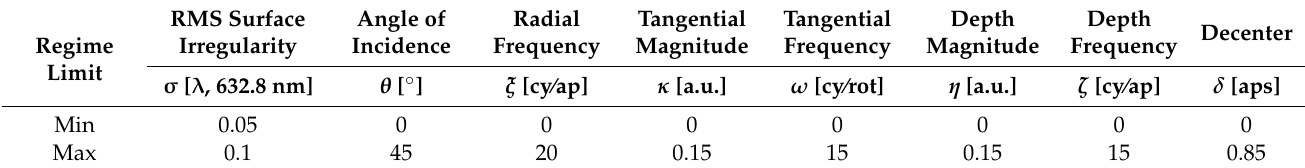
Table 7. Regime of Parameters Analyzed.